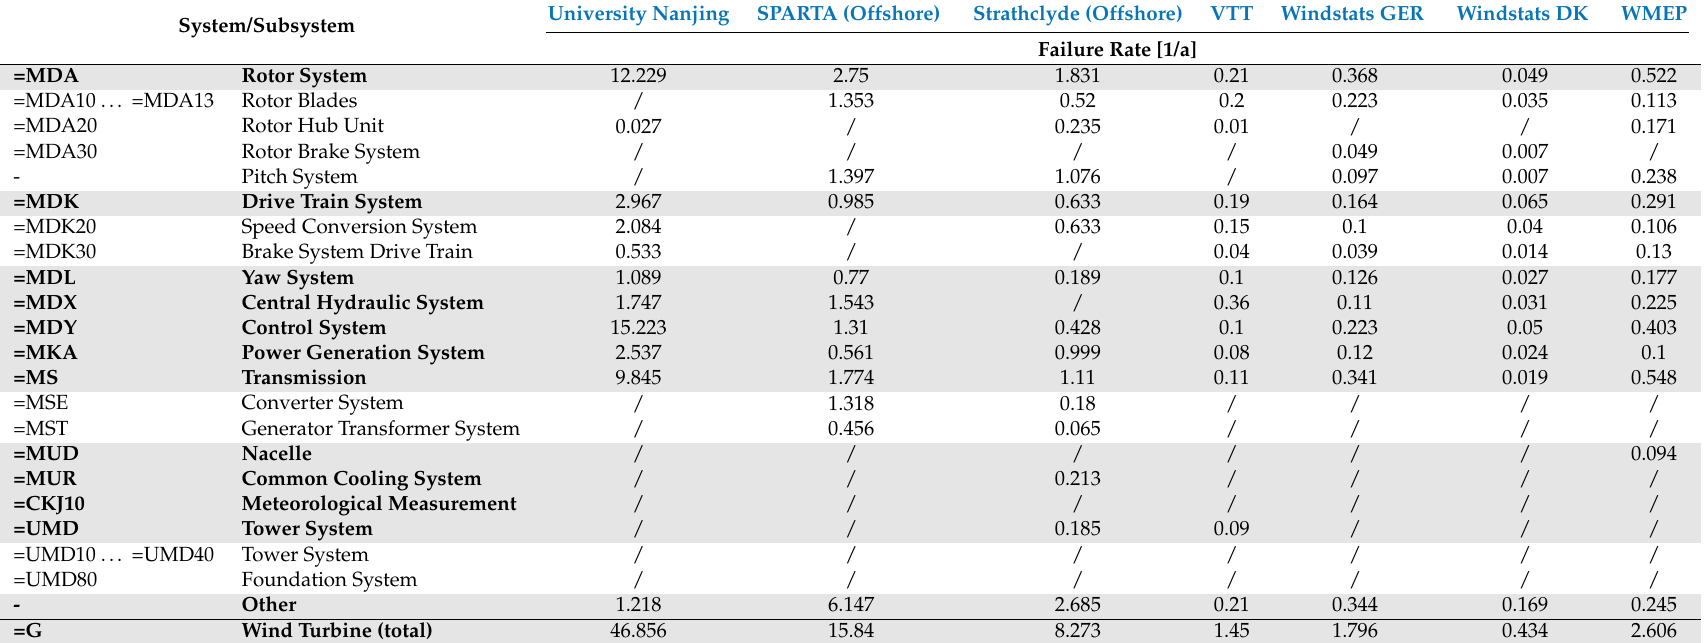
Table 5. Average failure rate per WT as published by different initiatives (part